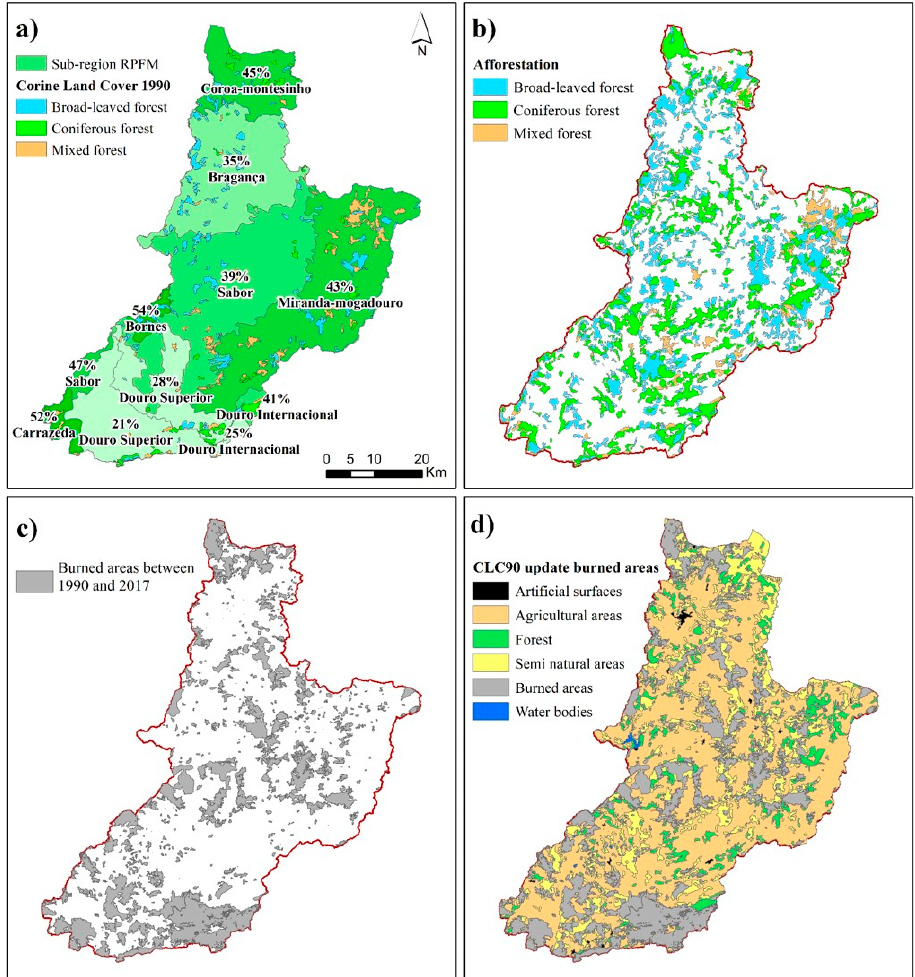
Figure 7. The maps of afforestation and wildfires scenarios inserted in the SWAT for constructing the hydrological models were ( a ) broad-leaved, coniferous, and mixed forest from the CORINE Land Cover 1990 and the projected percentages of afforestation per sub-region for 2045, proposed by the Regional Plan for Forest Management; ( b ) the afforestation projection for 2045; ( c ) areas burned between 1990 and 2017; and ( d ) the CORINE Land Cover 1990 updated with areas burned between 1990 and 2017.